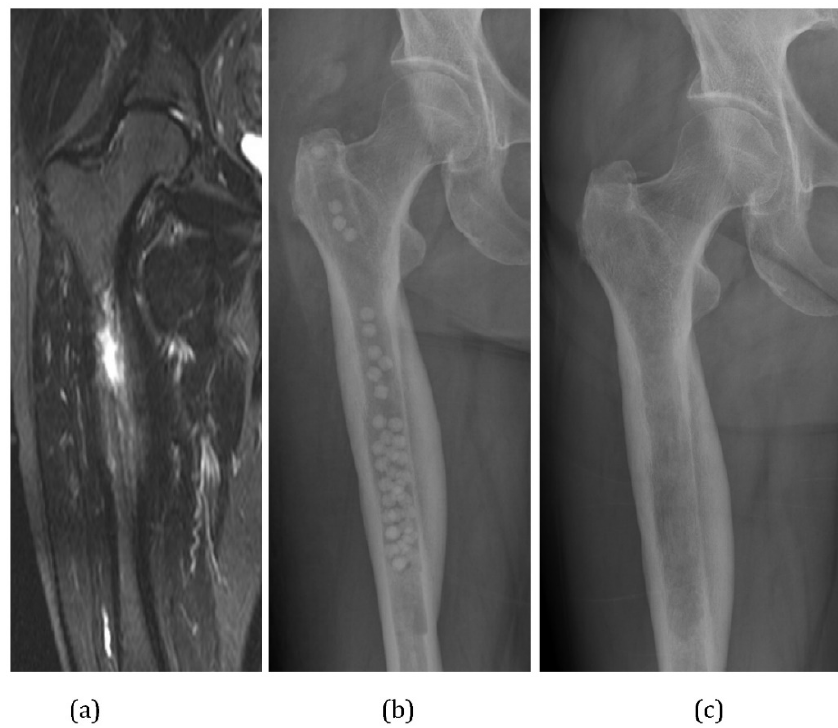
Figure 4. (A) This diabetic patient presented with a haematogenous infection of the medullary canal of the upper femur (Cierny & Mader Type I). The MRI shows the extensive medullary oedema, intramedullary abscess and cortical involucrum. (B) The infection was excised by medullary reaming and the dead space filled with Calcium Sulphate pellets with gentamicin. (C) At 4 months after surgery, the pellets have